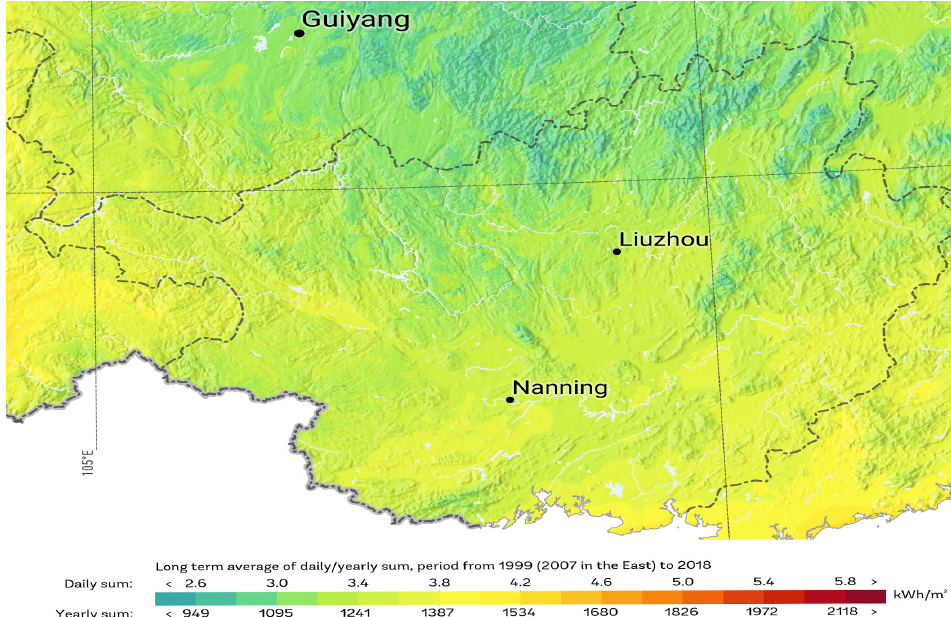
Figure 2. Guangxi annual average horizontal irradiation map from 2007 to 2018 [58].